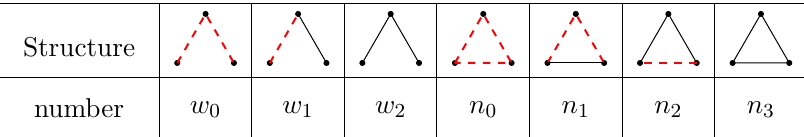
Figure 7 . Graph completion for a 3-vertex graph and 4-vertex graph. The resulting graphs have edges between each pair of vertices. This is equivalent to the edge-2 coloring (i.e. that we use two di(cid:11)erent colors to color a graph) of complete graphs (i.e. graphs where each pair of vertices is connected by an edge).